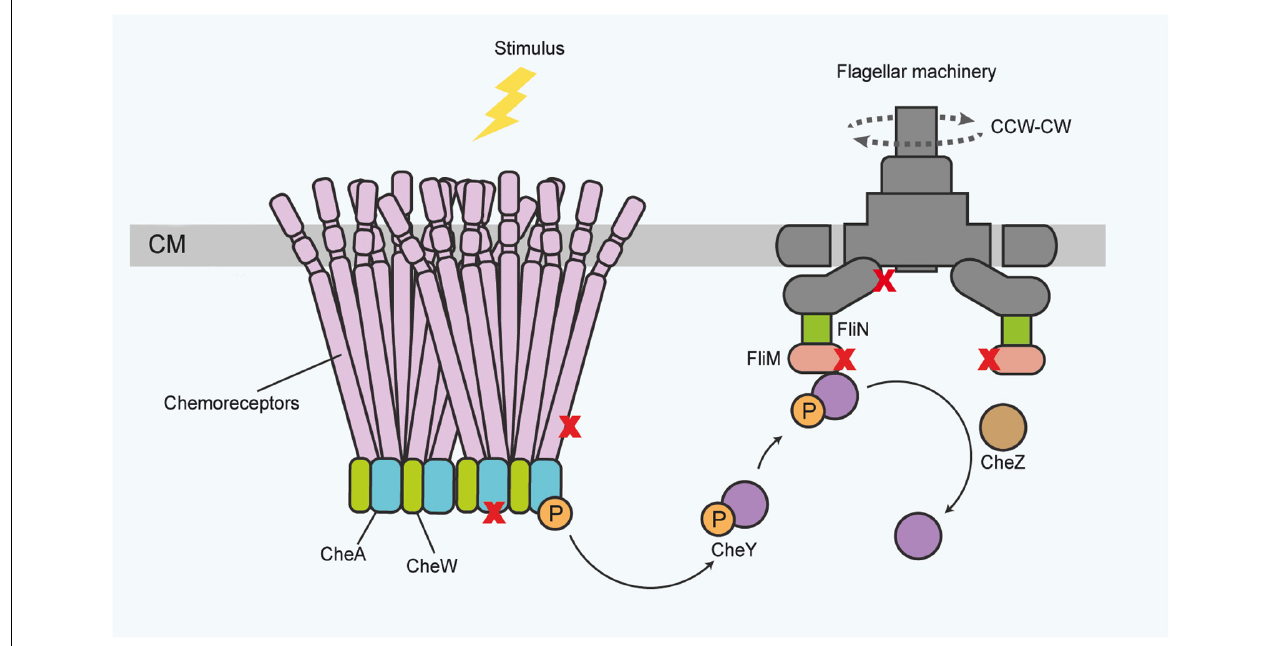
FIGURE 1 | General scheme of the canonical chemotactic sensing and signaling pathway in the bacterial membrane for governing motility functions, which are also accessible for protein activity sensing. Receptor proteins associate in large complexes of trimers of dimers, spanning the inner membrane toward the cytoplasm. In the cytoplasm, the receptors associate with the histidine kinase CheA and the adaptor protein CheW. Upon stimulus binding, CheA autophosphorylates. Subsequently the response regulator protein CheY activates and translocates the information to the flagella motor proteins, ultimately inducing a change in the direction of flagella rotation (dotted lines) or flagellar speed. The chemotaxis components, and flagellar basal body proteins, for instance the FlhA and FliM proteins, also provide a regulatory platform for diverse activity inputs and protein-protein interactions (symbolized by X). Phosphorylated CheY can be dephosphorylated for signal termination by various proteins, for instance CheZ. CM, cytoplasmic membrane; P, phosphoryl group. CW – clockwise; CCW – counterclockwise (for the direction of flagellar rotation). The top of the panel points to the outside of the bacterial